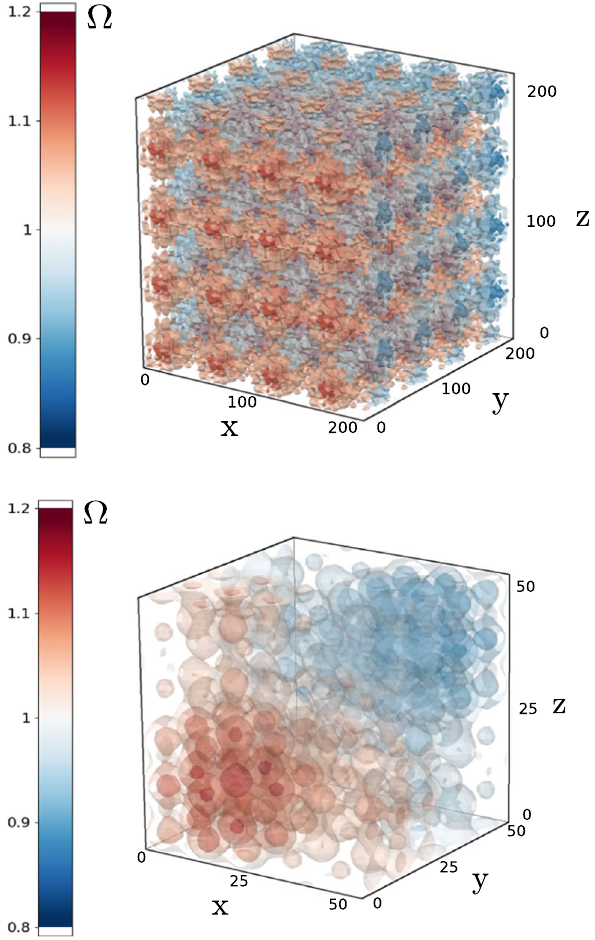
Fig. 1 Top: The model isodensity surfaces at t ( EdS ) infinite, periodic lattice. Bottom: The density distribution within the elementary